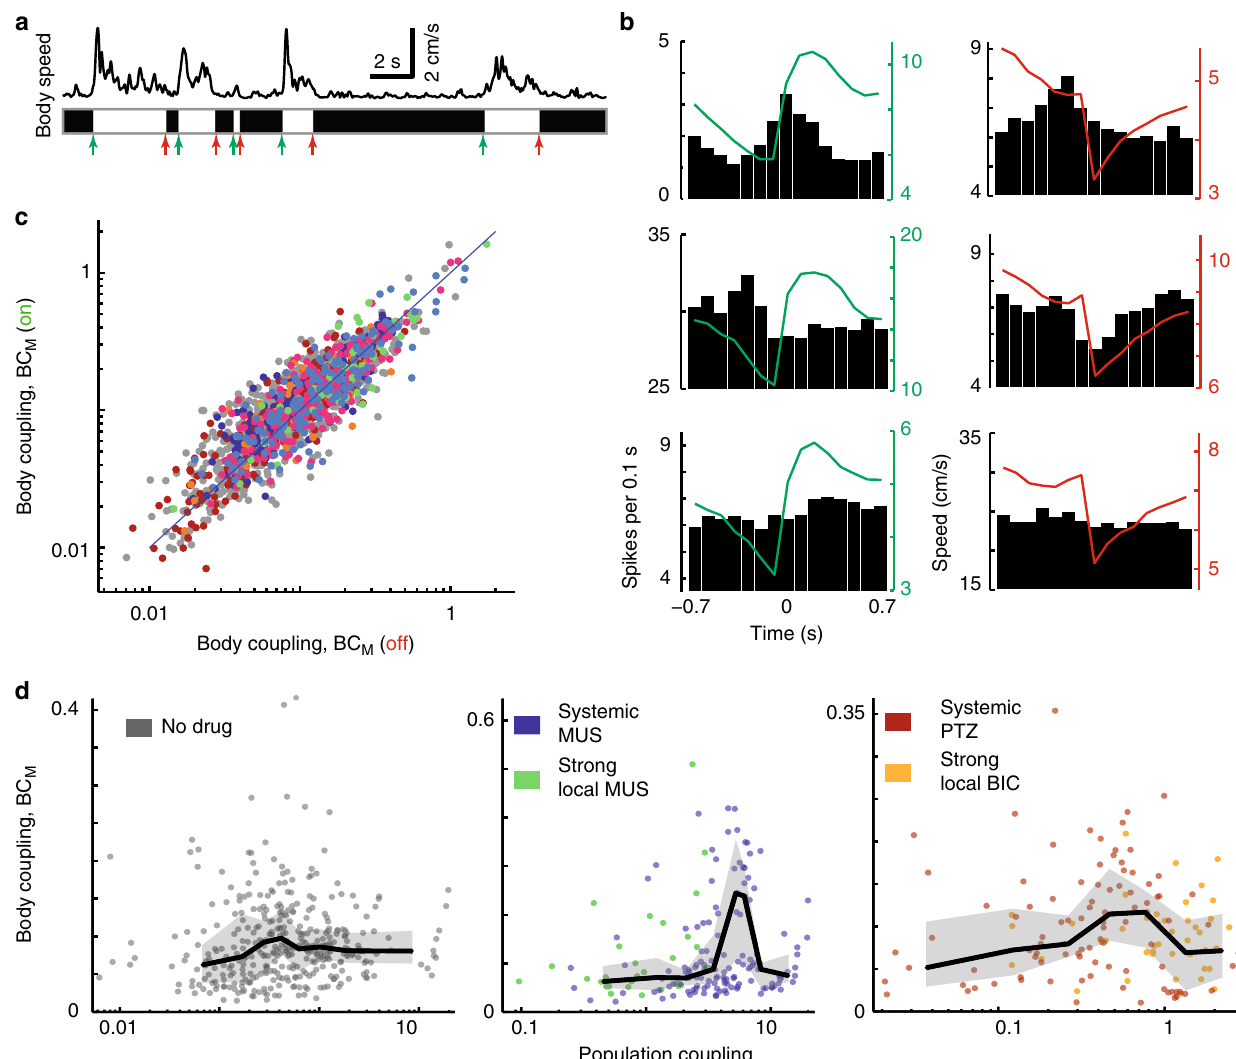
Fig. 4 Body coupling BC M peaks at optimal weak population coupling. a We de fi ned “ body coupling ” BC M for each unit based on how much its fi ring rate is modulated at body movement onset (green arrows) and cessation (red arrows). Movement onset and cessation were de fi ned by when the average body speed increases above and drops below its mean, respectively. b Example movement-triggered-average spike rate histograms (black) show wide variety of relationships between spiking and movement. Movement onset (green) and movement cessation (red) were considered. Red and green lines show change in body speed averaged over the onset and cessation event trigger times. c Single units whose spike rate was strongly modulated by movement onset were also modulated by movement cessation. d We observed a peaked relationship between BC M and population coupling. Enhancing inhibition made the peaked relationship between body coupling and population coupling more prominent and shifted it toward higher population coupling. Line indicates moving average. Shaded region delineates